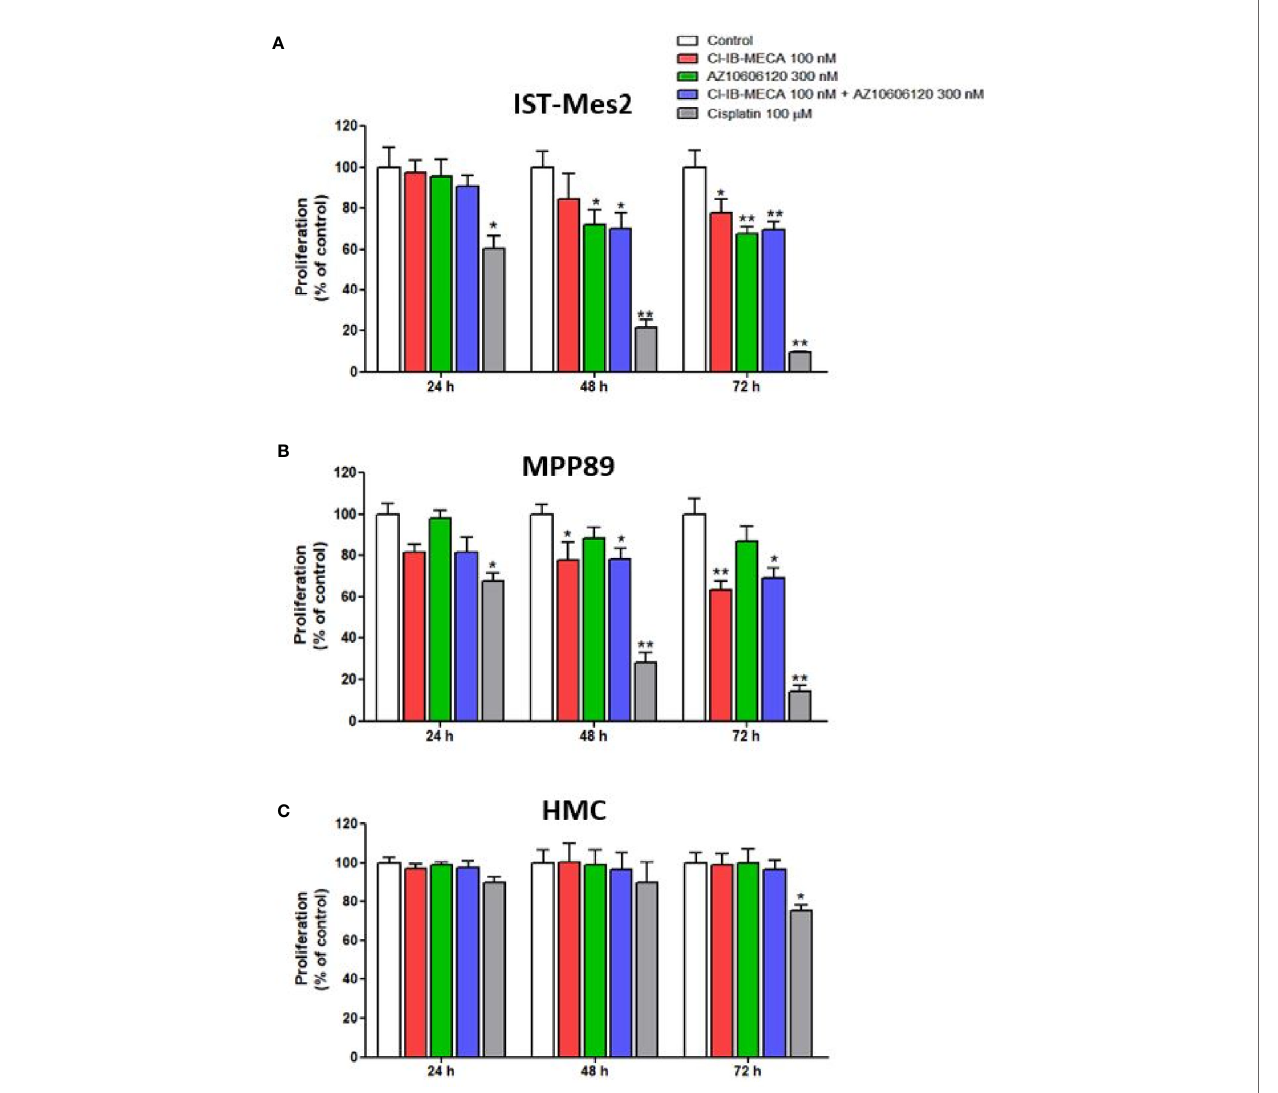
FIGURE 3 | Impact of A 3 AR agonist and P2X7R antagonist on cell proliferation. Effect of Cl-IB-MECA (100 nM), AZ10606120 (300 nM), alone or in combination, in comparison to cisplatin 100 µM on cell proliferation in IST-Mes2 (A) and MPP89 (B) cells as well as in HMC cells (C) . Results are represented as mean ± standard error of mean (SEM) of n=3 independent experimental replicates. *p < 0.05 vs control; **p < 0.01 vs